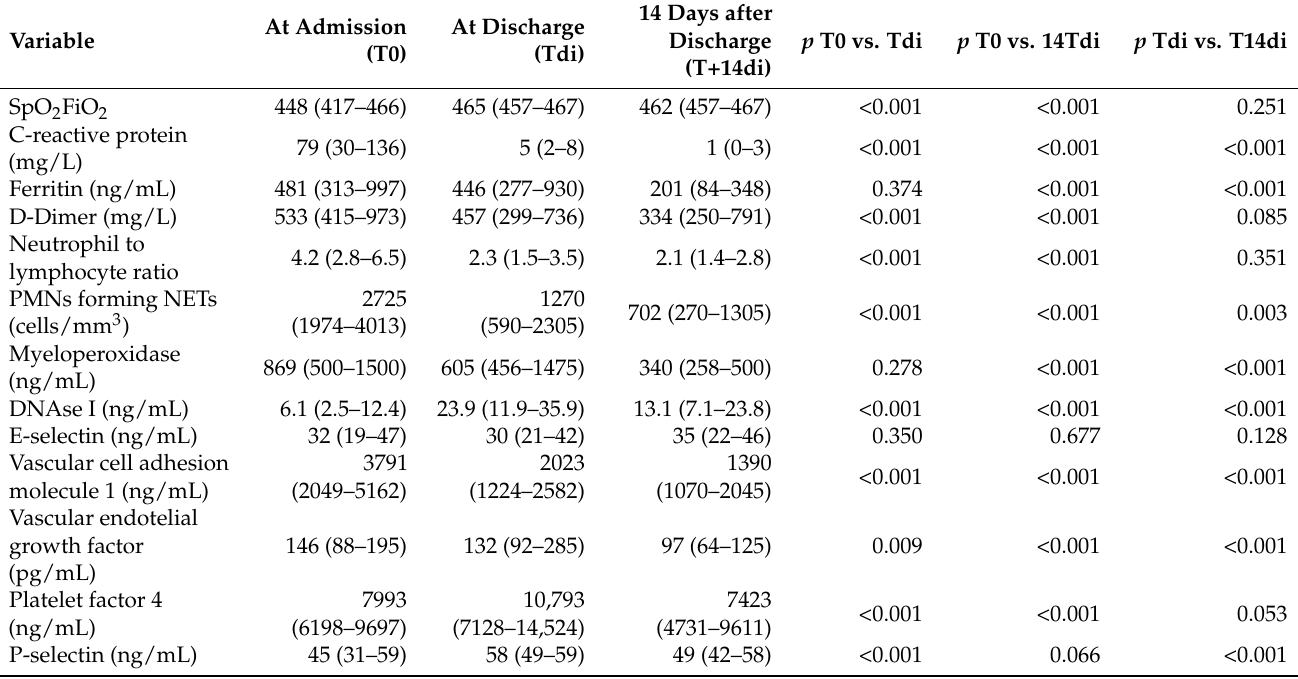
Table 4. Outcomes in surviving patients with pneumonia by SARS-CoV-2 ( n = 80).